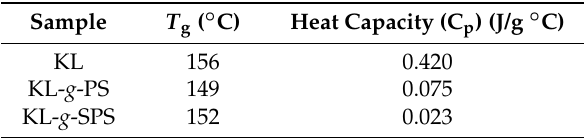
Table 3. T g and heat capacity of the KL, KL- g -S, and KL- g